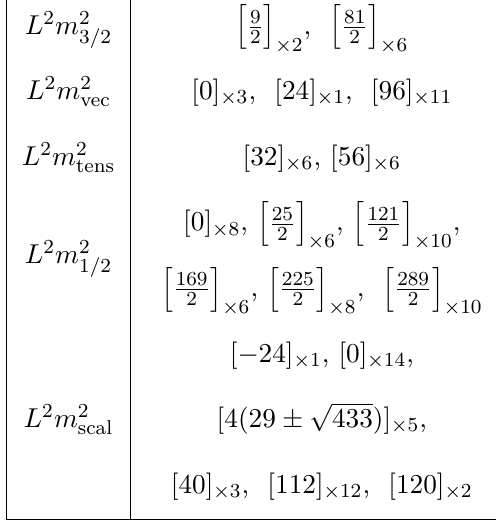
Table 13 . Masses for the dS vacuum D1. Table 14 . Masses for the dS vacuum